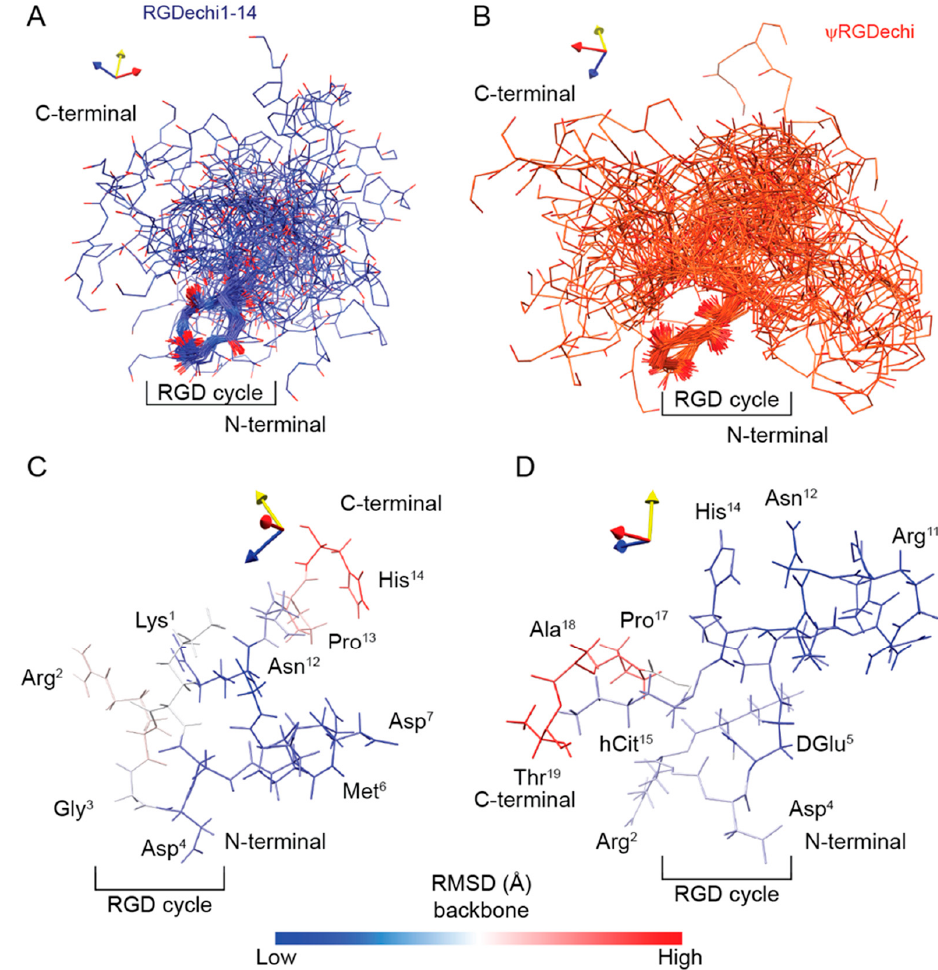
Figure 7. Conformational ensembles of RGDechi1-14 and ψ RGDechi. ( A , B ) Conformational ensembles obtained integrating MD simulations data with experimental NMR chemical shifts. Each structural ensemble was generated by selecting the 50 structures having the lowest global CS-RMSD function. In both ensembles the conformers were aligned with respect to the RGD cycle region from Lys1 to DGlu5. ( C , D ) Backbone RMSD values reported on the representative structure (conformer with the lowest CS-RMSD function) for RGDechi1-14 and ψ RGDechi peptides.